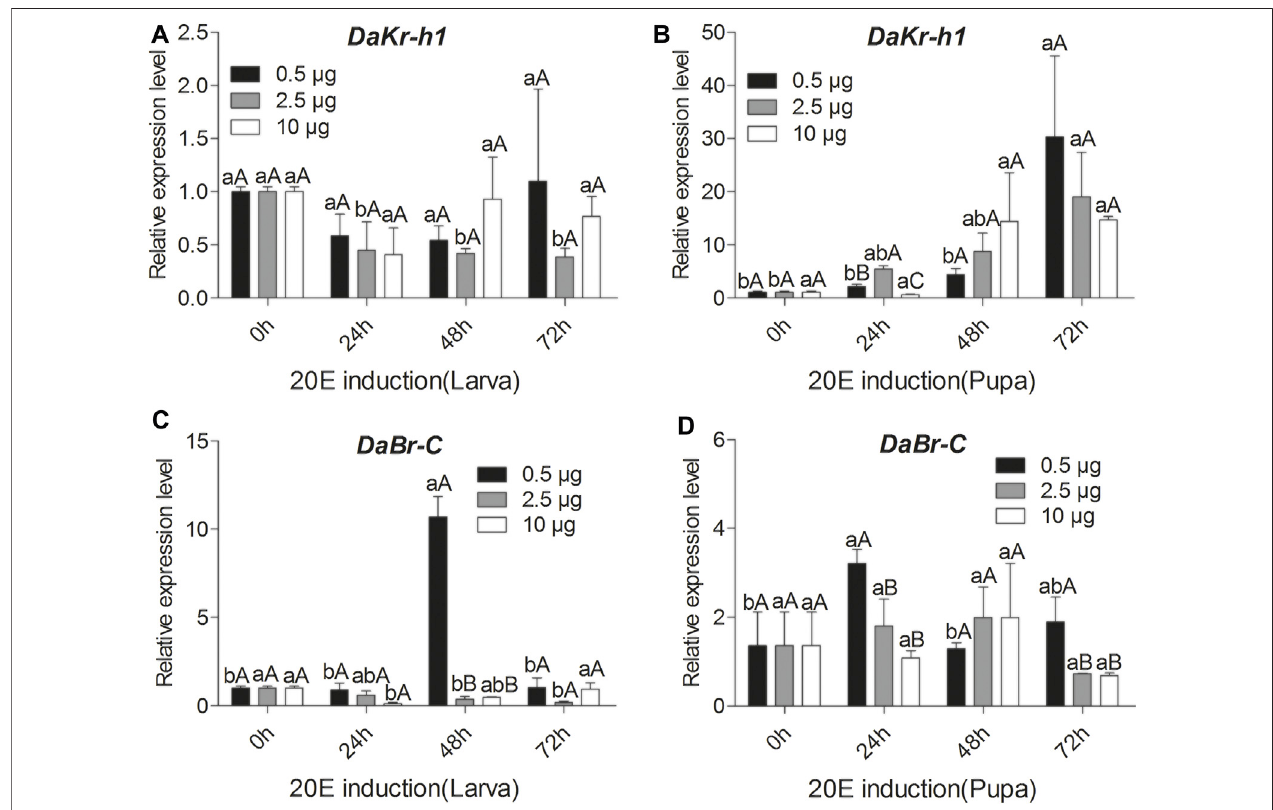
FIGURE 5 | Quantitative expressions of DaKr-h1 and DaBr-C genes with the ecdysteroid 20-hydroxyecdysone (20E; 0.5, 2.5, 10 μ g) at different larval and pupal stages. Transcript levels of (A) DaKr-h1 in larvae, (B) DaKr-h1 in pupae, (C) DaBr-C in larvae, and (D) DaBr-C in pupae. Data are means ± SE of three independent experiments.Inbothgraphs,transcriptlevelsareshownrelativetoethanol-treatedlarvaeandpupae(control).Alltemplateswerenormalizedwith CYP4G55 and β -actin . The 2 − ΔΔ Ct and SE values were used for plotting the graphs. Different letters indicate signi fi cant differences at p < 0.05 (two-way ANOVA). Uppercase letters indicate signi fi cant differences of concentration at the same time, whereas lowercase letters indicate signi fi cant differences of time at the same concentration.